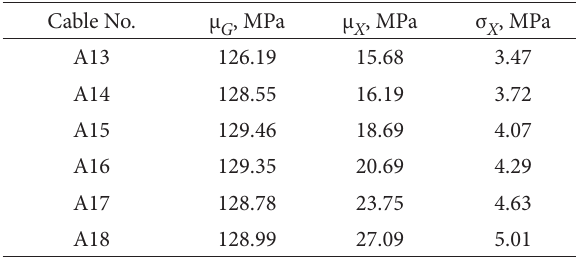
Table 2. Statistical parameters of cable stress under dead load of bridge and random vehicle load Cable